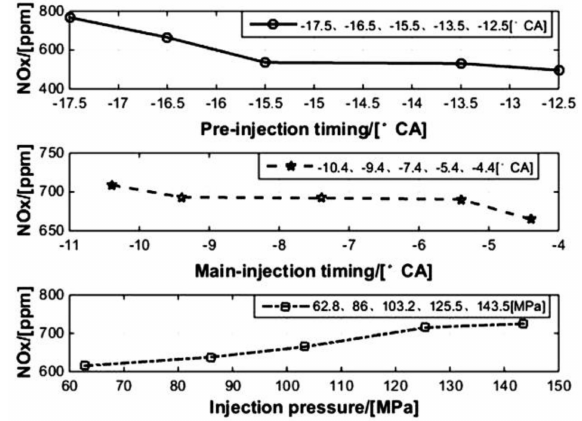
Figure 6. Effects of different injection parameters on NO x emissions.